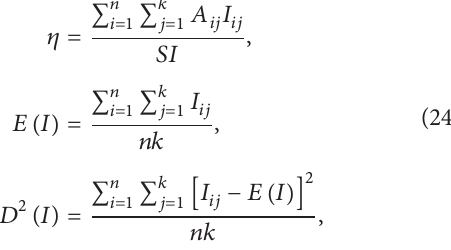
with the positions away from the symmetry axis of 4.0 mm, 8.1 mm, 12.0 mm, 15.4 mm, and 19.1 mm,